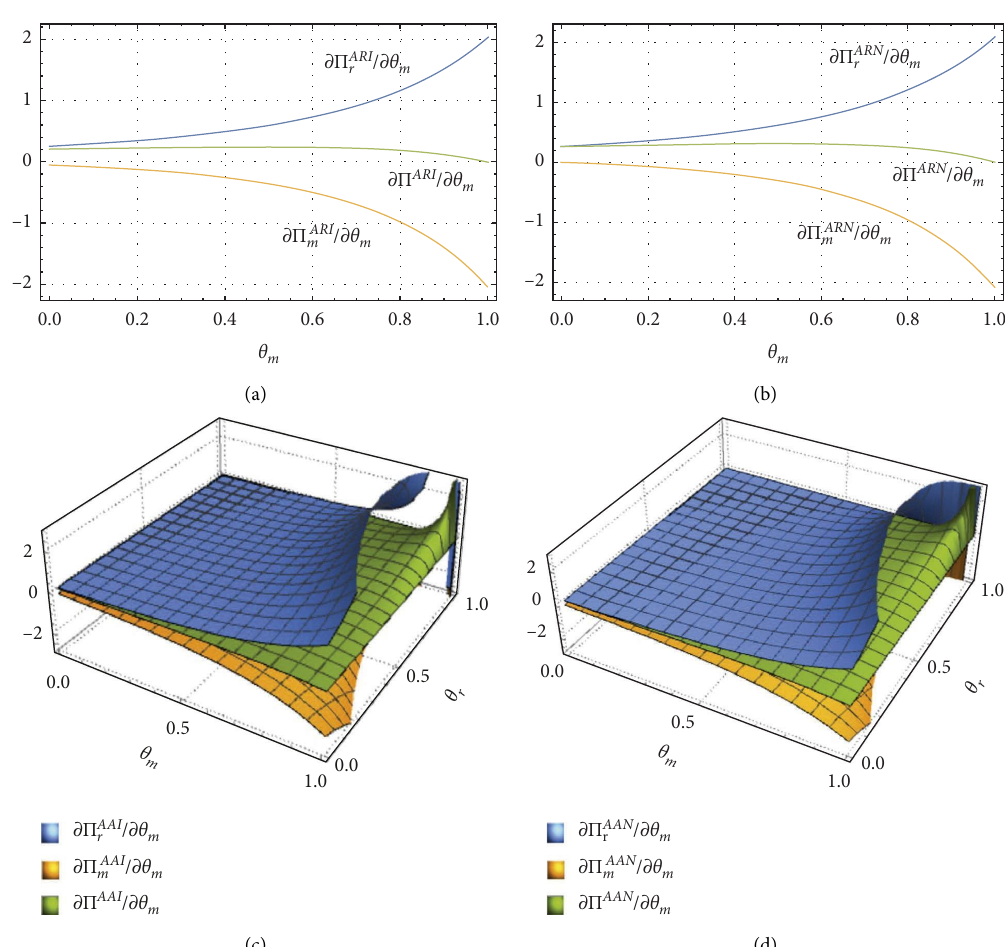
Figure 11: Infuence of the manufacturer’s altruistic preference on profts ( a � 1 , b � 0 . 5 ,c � 0 . 2 , c � 1 ) . (a) In scenario ARI. (b) In scenario ARN. (c) In scenario AAI. (d) In scenario